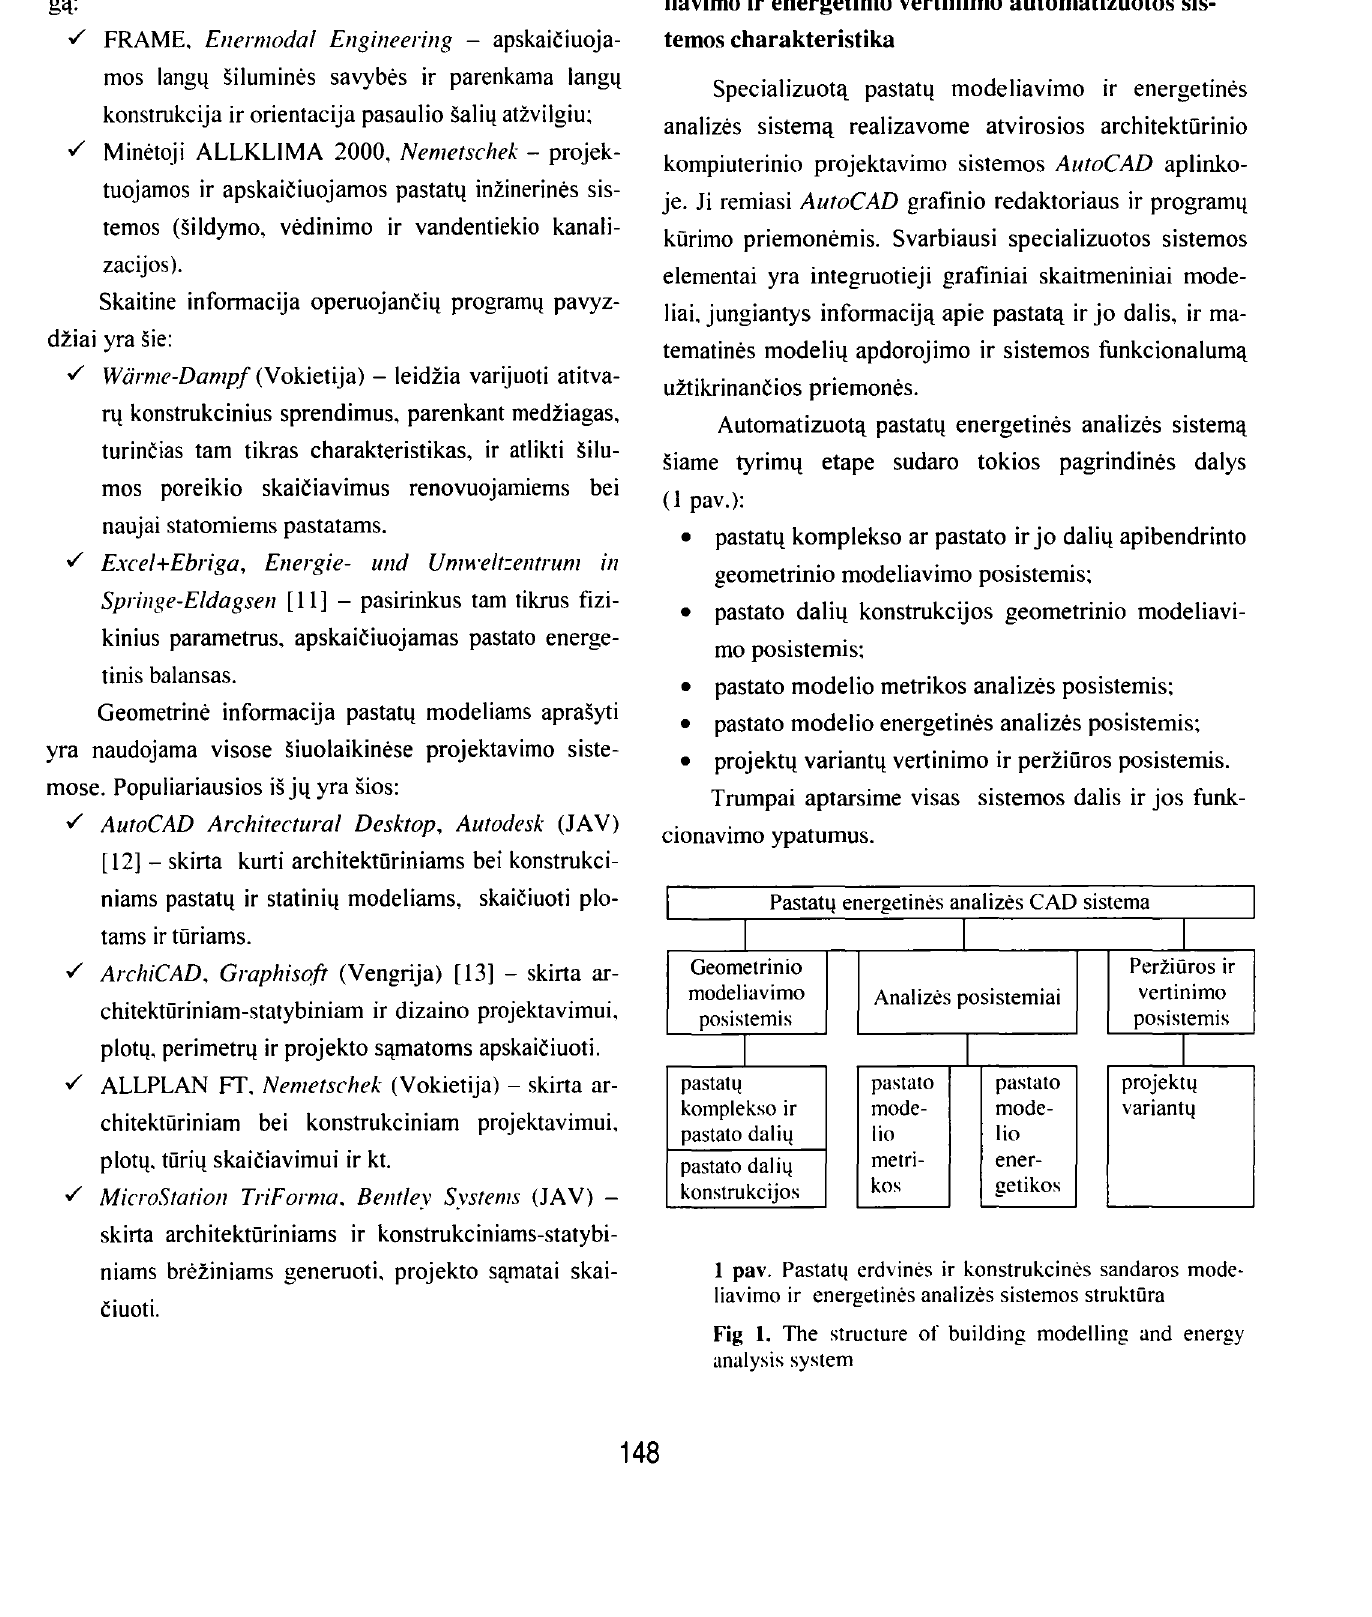
Fig 1. The structure of building modelling and